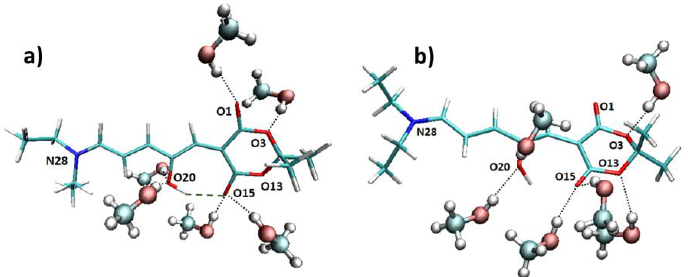
Figure 4. Two representative snapshots from the MD trajectory, depicting the two main hydrogen